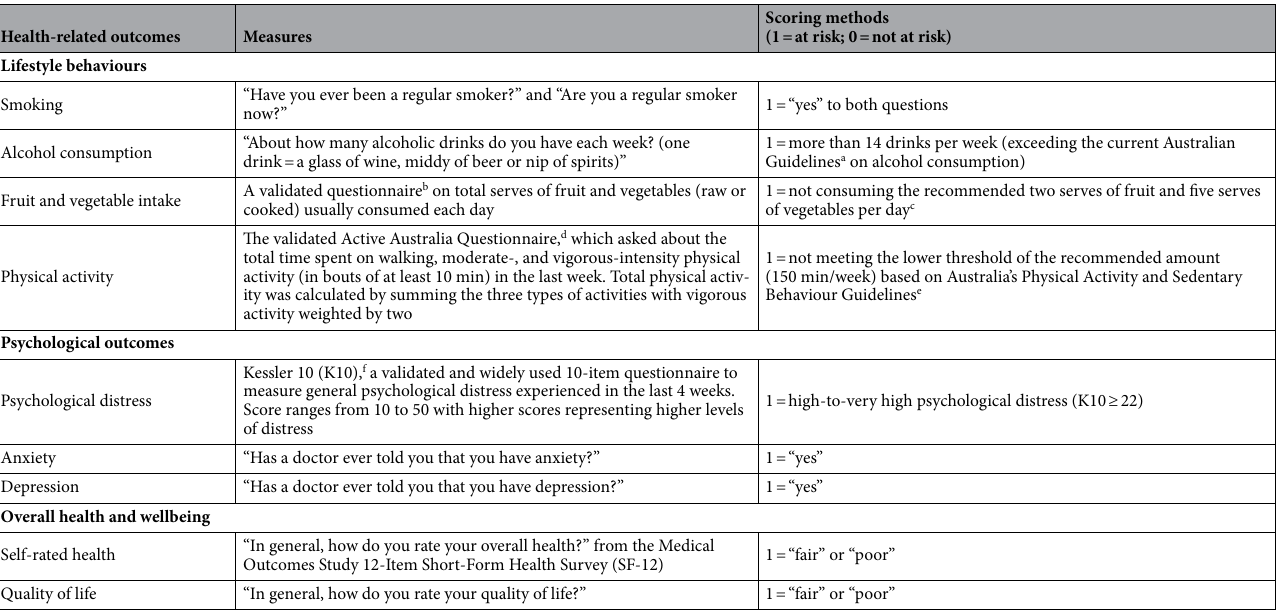
Table 1. Measures and scoring of health-related outcomes in the 45 and Up Study. a Australian